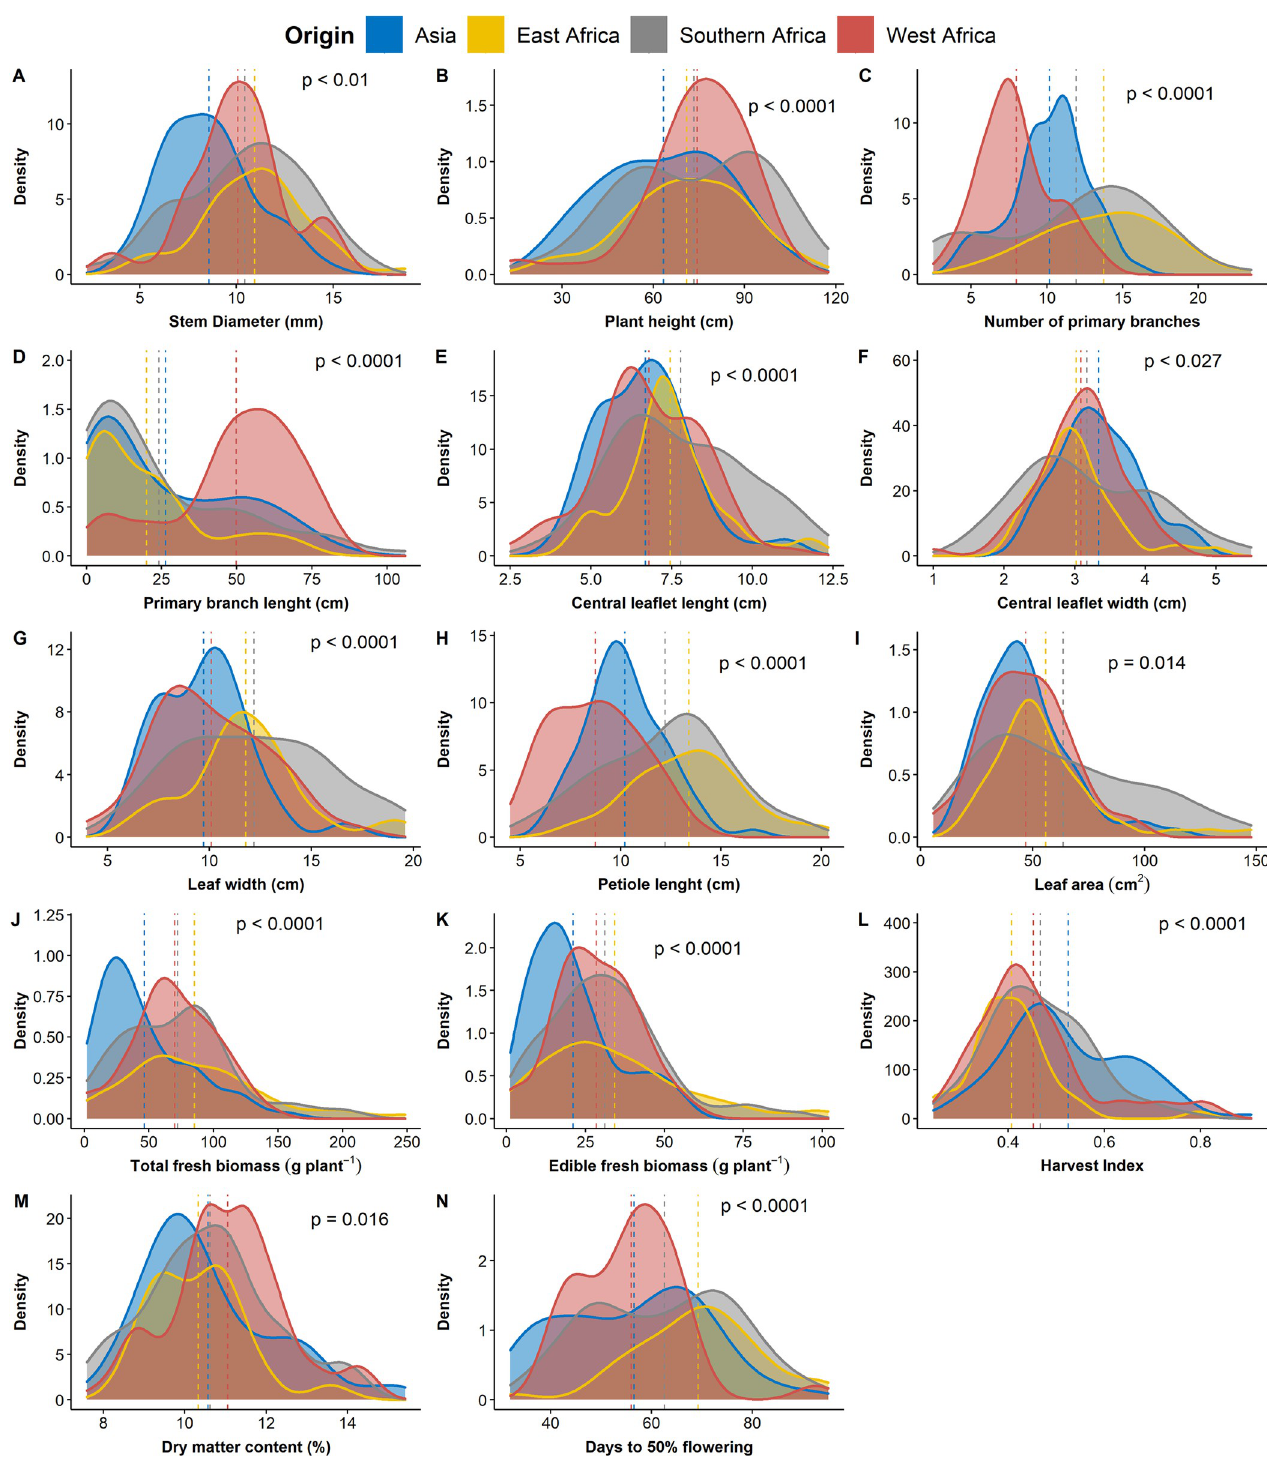
Fig 1. Distribution of phenotypic values for fourteen agronomic traits among regions of origin of 71 advanced lines of Gynandropsis gynandra . (A) stem diameter (mm). (B) Plant height (cm). (C) Primary branch length (cm). (D) Number of primary branches. (E) Central leaflet length (cm). (F) Central leaflet width (cm). (G) Leaf width (cm). (H) Petiole length (cm). (I) Leaf area (cm 2 ). (J) Total fresh biomass per plant (g). (K) Edible fresh biomass per plant (g). (L) Harvest index. (M) Dry matter content (%). (N) Days to 50% flowering (days). The mean of each population of regions of origin is indicated by a dotted line.